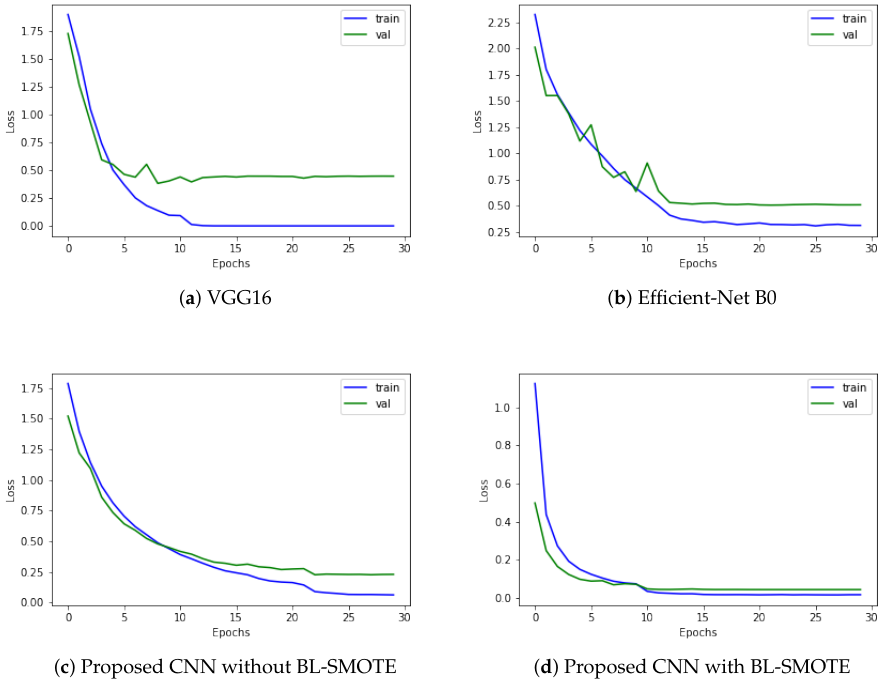
Figure 12. Training process loss of ( a ) VGG16, ( b ) Efficient-Net B0, and ( c , d ) proposed deep CNN model with and without